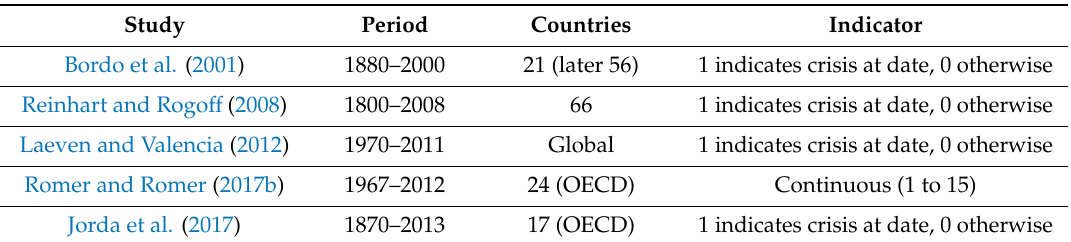
Table 2. Crisis data